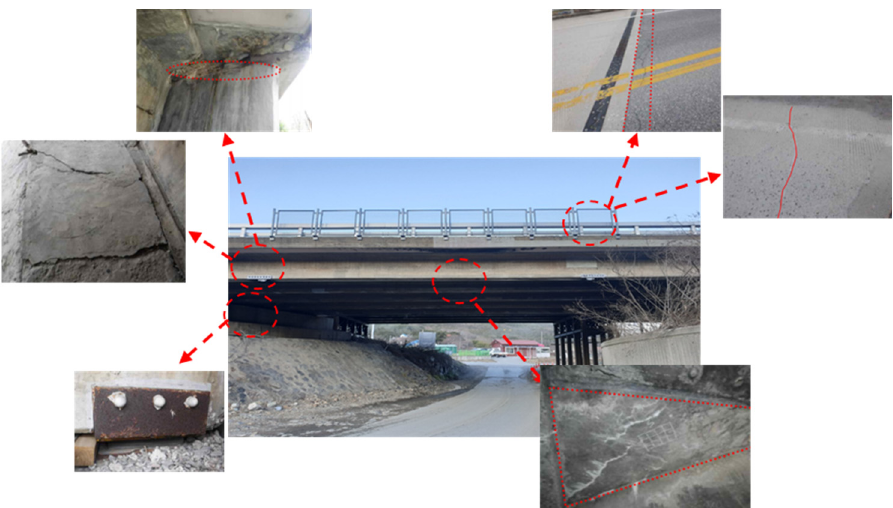
Figure 1. Bridge before demolition.